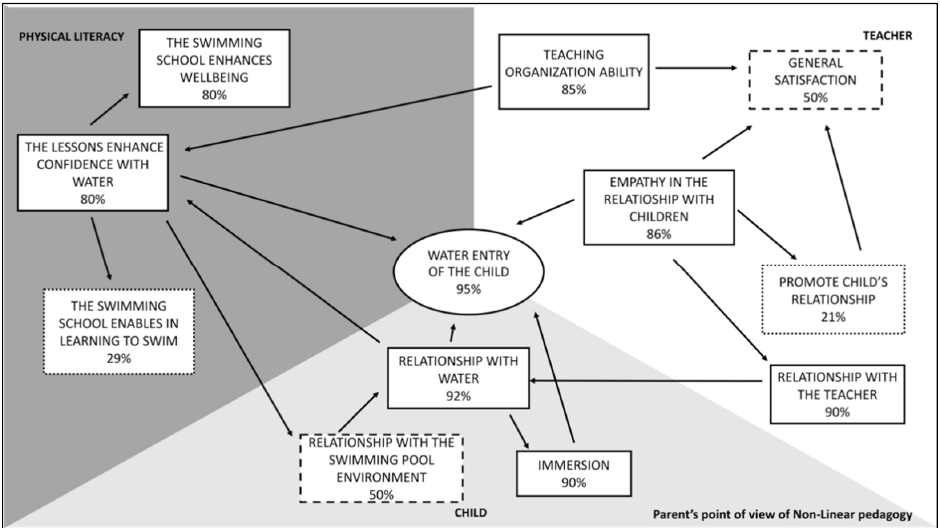
Figure 3. Diagram related to the perception of NL parents’ group according to the results of the questionnaire administered.